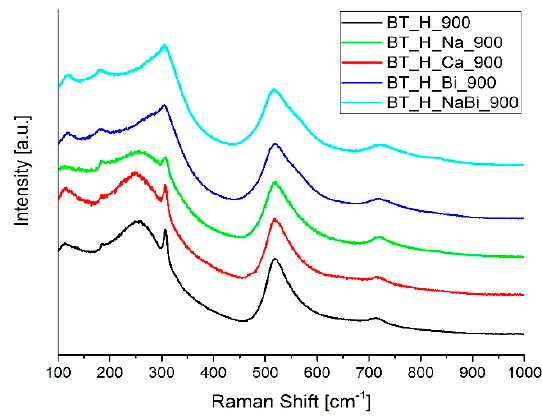
Figure 12. Raman spectra of cation − doped BaTiO 3 systems: (black line) undoped sample, (red line) BT_H_Ca_900 sample, (green line) BT_H_Na_900, (blue line) BT_H_Bi_900, (light blue line) BT_H_NaBi_900.